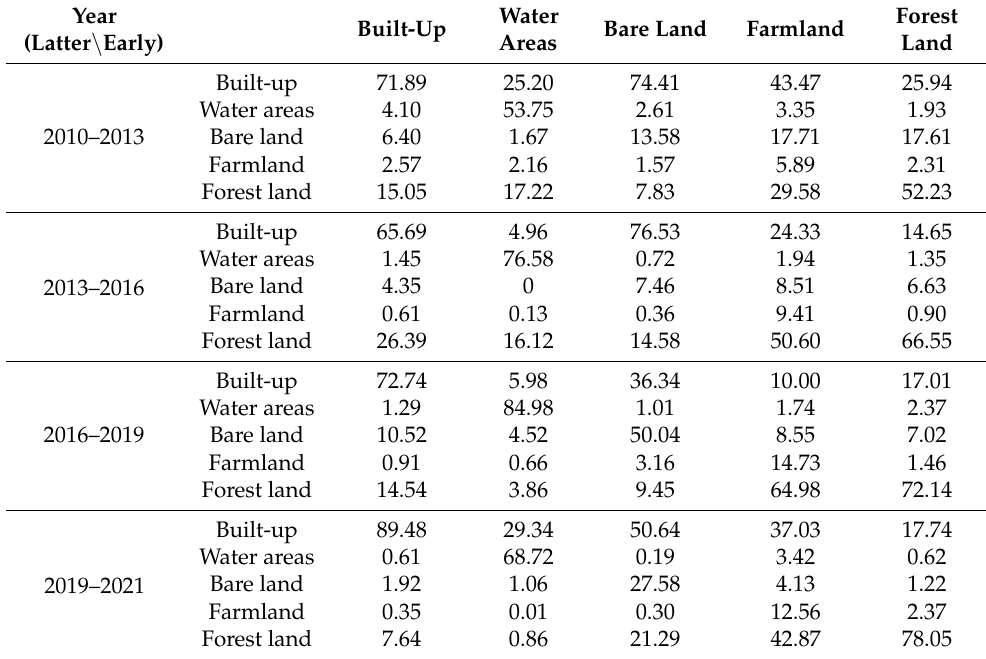
Table 5. Land-use area transfer matrix 2010–2021